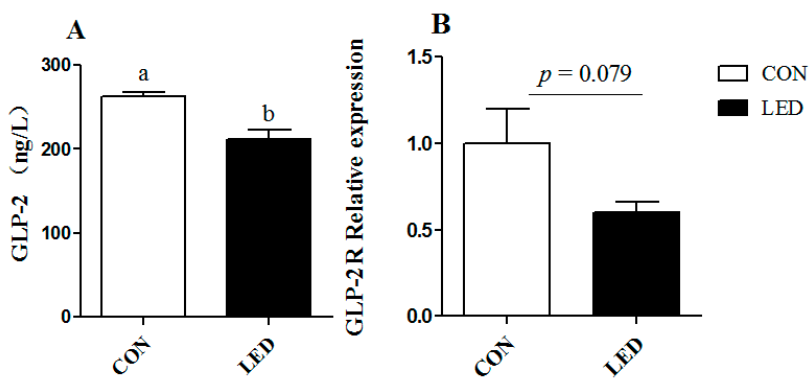
Figure 4. Effect of different energy level during gestation on plasma GLP-2 concentration ( A ) and GLP-2R mRNA expression ( B ) in the ileum of newborn pigs. Values are expressed as mean values with their standard errors; means with different superscript letters are significantly different ( p < 0.05); the replicated number of each group is 6.